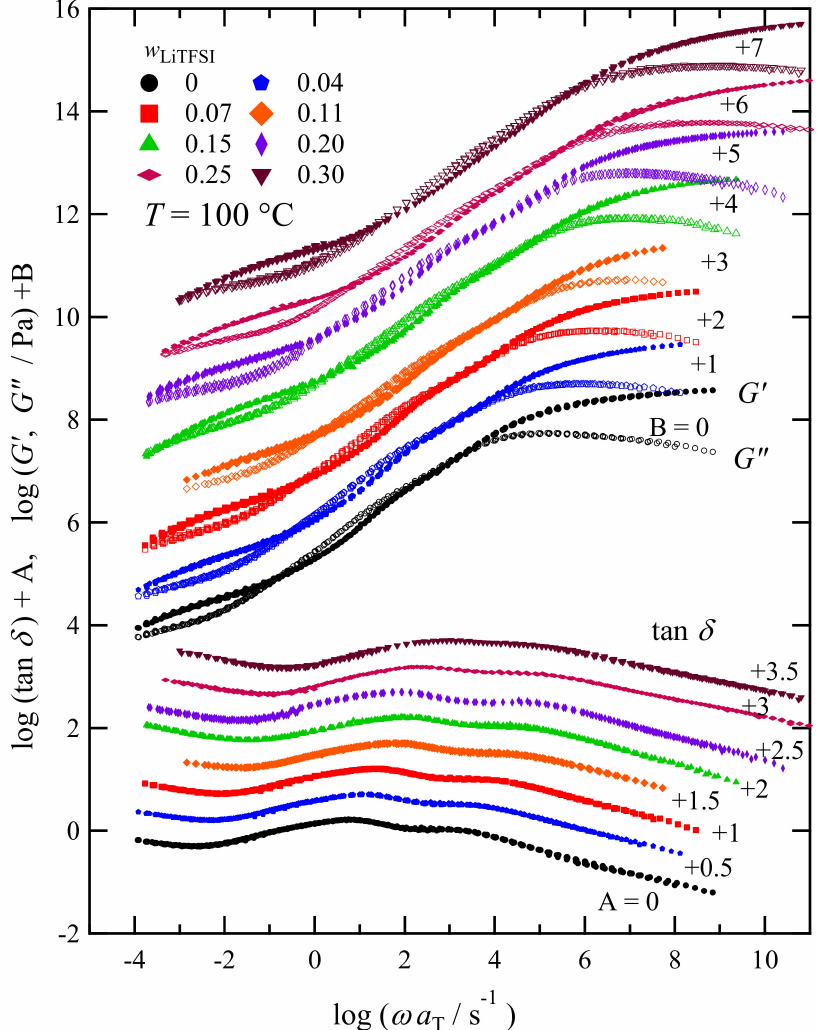
Figure 7. Angular frequency dependence of G (cid:48) (unfilled markers), G (cid:48)(cid:48) (filled markers), and tan δ for PC 4 -TFSI/LiTFSI mixtures with various LiTFSI concentrations at T = 100 ◦ C. Each spectrum is vertically shifted with the factors B and A as indicated in the figure to avoid data